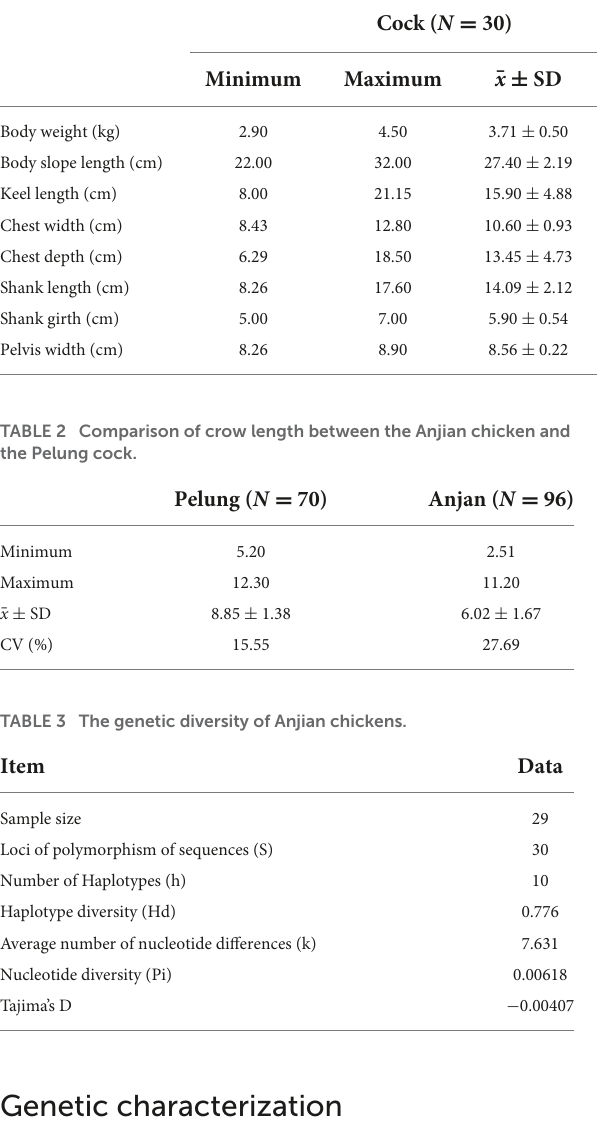
According to the genetic distance between breeds ( Table 4